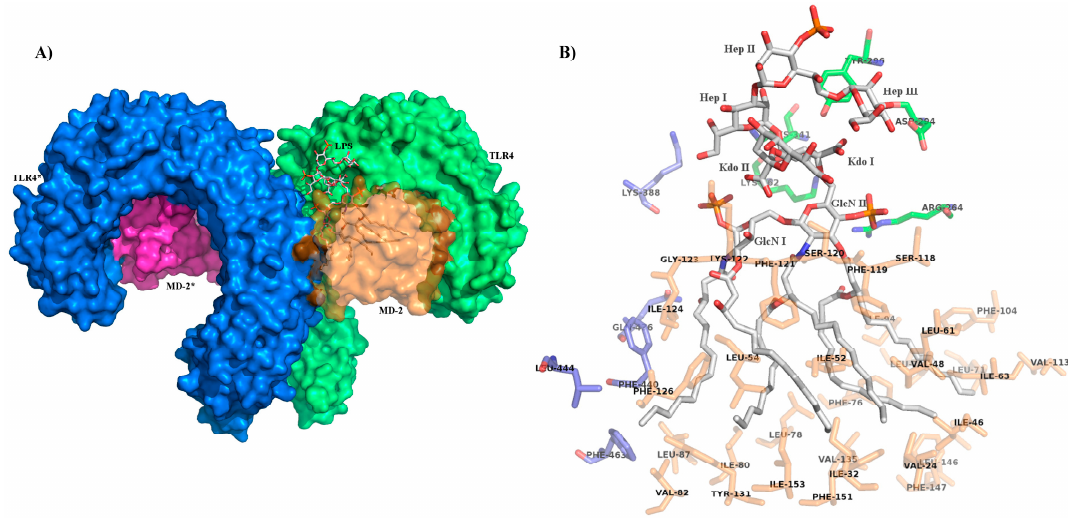
Figure 4. Picture of the interactions between LPS, (TLR4/MD-2) complexes ( A ) (TLR4/MD-2/LPS) 2 signalling complex; ( B ) E. coli Lipid A with inner-core and its interactions with MD-2 (residues in orange) and TLR4 (residues in green) of the same complex and with the second TLR4 molecule, TLR4* (blue), as observed by crystallography (PDBID: 3FXI). LPS is displayed in gray for carbon atoms, red for oxygen, blue for nitrogen and dark orange for phosphate.